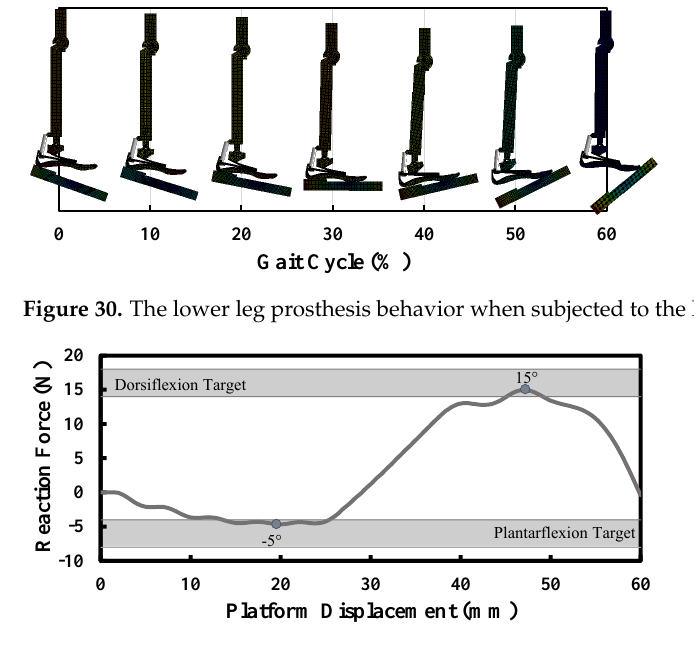
Figure 31. The rotation of the foot prosthesis when subjected to the ISO 22675 roll-over test.